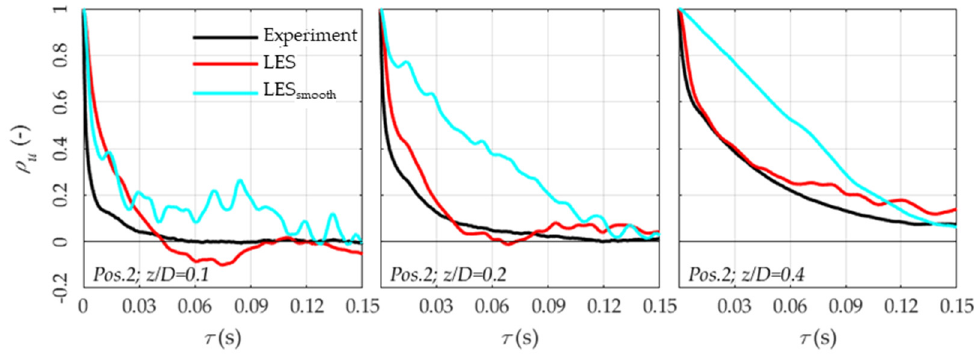
ffi cient for position 1 at two heights, z / D = 0.1 and 0.6. Figure 13. Autocorrelation coefficient for position 1 at two heights, z/D = 0.1 and 0.6. Figure 13. Autocorrelation coe